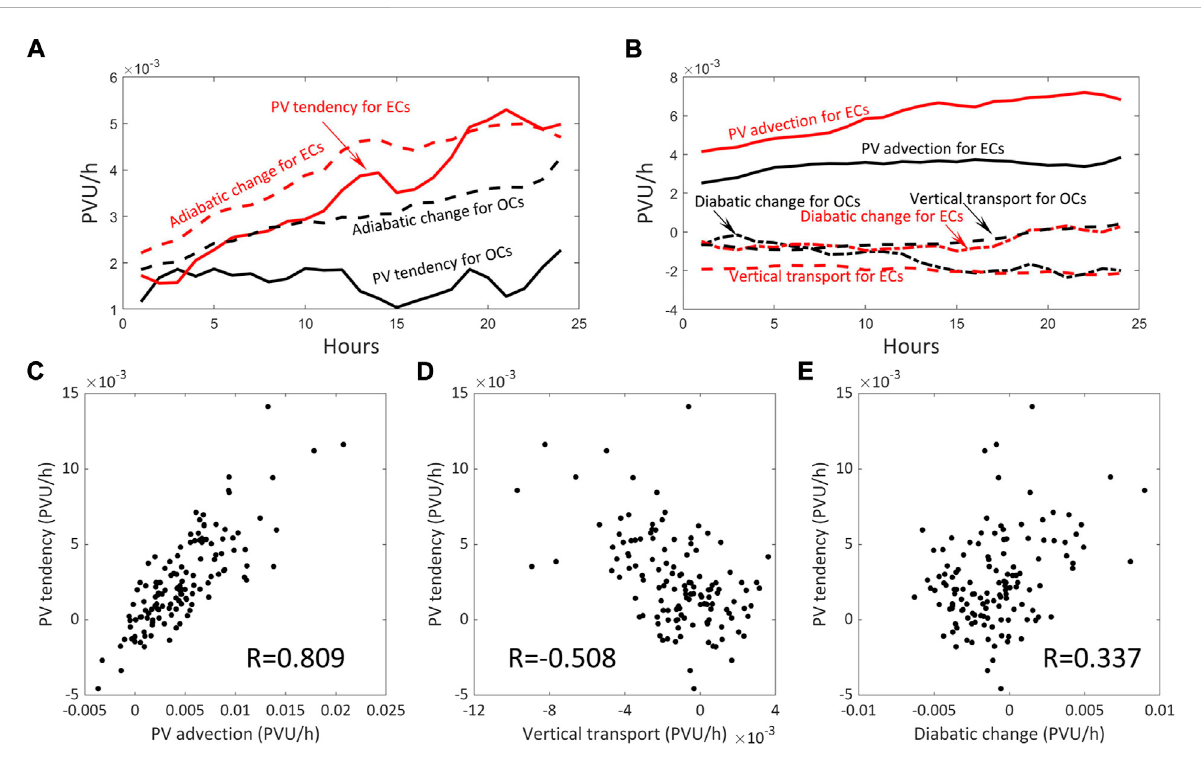
FIGURE 7 Contribution of PV advection, vertical transport, and diabatic change to PV tendency. The upper row shows the variation of each term during initialdevelopmentaveragedamongOCs(blacklines)andECs(redlines).ThelowerrowshowsthedistributionofPVtendencyandPVadvection (C) / vertical transport (D) /diabatic change (E) averaged during the initial 24 h for each cyclone, with R denoting the correlation coef fi